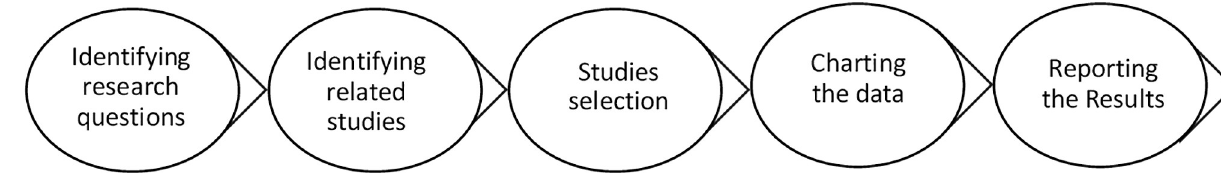
Fig 1. Scoping review process. Source: Adapted from Arksey and O’Malley